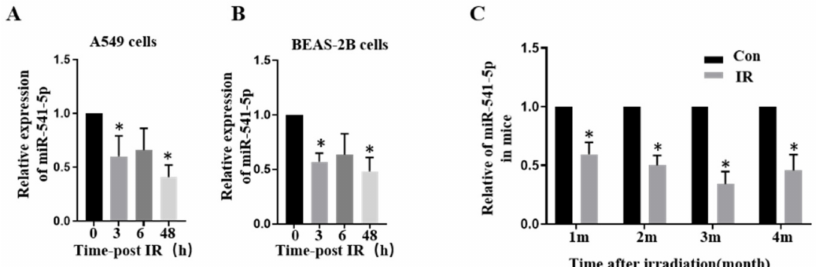
Figure 1. Ionizing radiation can reduce the expression of miR-541-5p. We used RT-qPCR at 0 h, 3 h, 6 h, and 48 h after 6Gy irradiation to detect miR-541-5p in A549 cells ( A ) and Beas 2B cells ( B ). ( C ) After 25Gy chest irradiation, lung tissues of mice were collected at the first, second, third, and fourth month, and the expression of miR-541-5p was detected by RT-qPCR. * p < 0.05 versus the